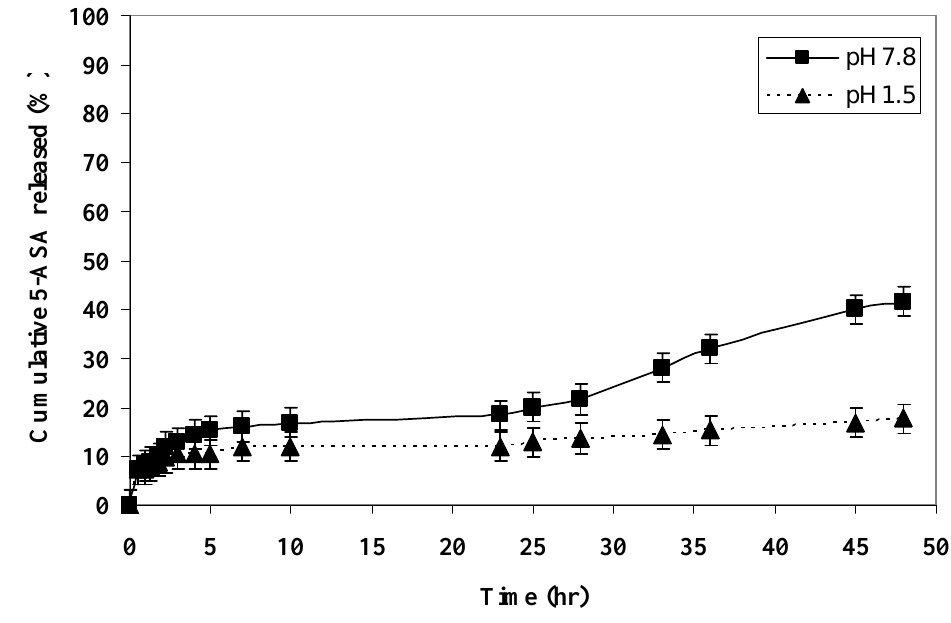
Figure 3. In vitro 5-ASA release from polymer VI in phosphate buffer solutions (pH 7.8 and 1.5) at 37 ºC.